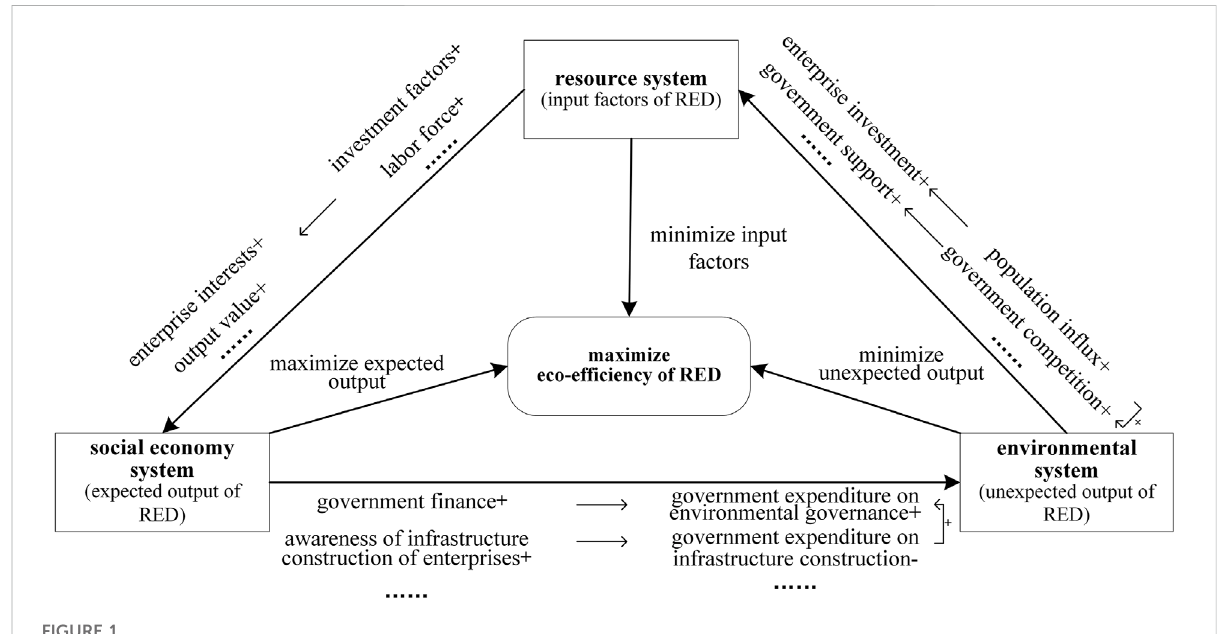
FIGURE 1 Connotation mechanism of the eco-ef fi ciency of